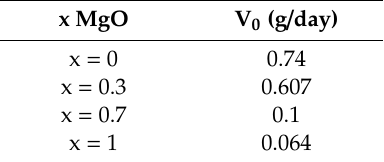
Table 3. Initial dissolution rates of 3P 2 O 5 -2K 2 O-(1 − x)CaO-xMgO (0 ≤ x ≤ 1) glasses at T = 25 ◦